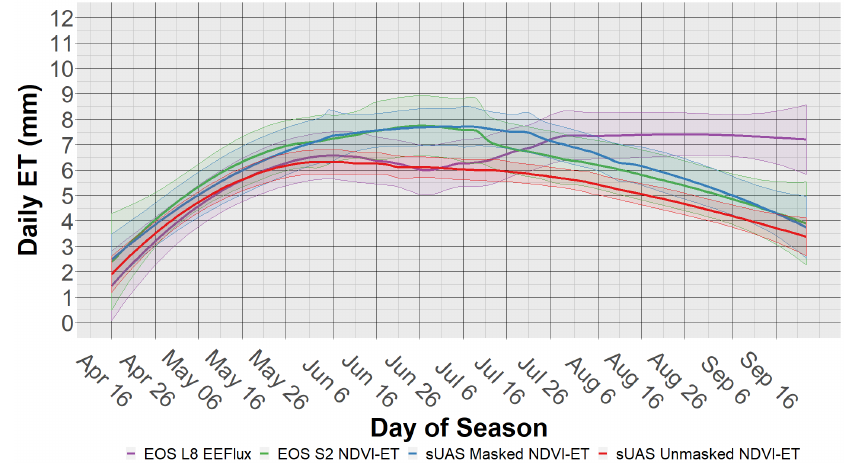
Figure 5. Seasonal Daily ET a in mm (y-axis) interpolated from loess model fit. Landsat 8 EEFlux is colored purple, Sentinel 2 NDVI-ET is shown in green, sUAS masked NDVI-ET is blue, and sUAS unmasked NDVI-ET is red.